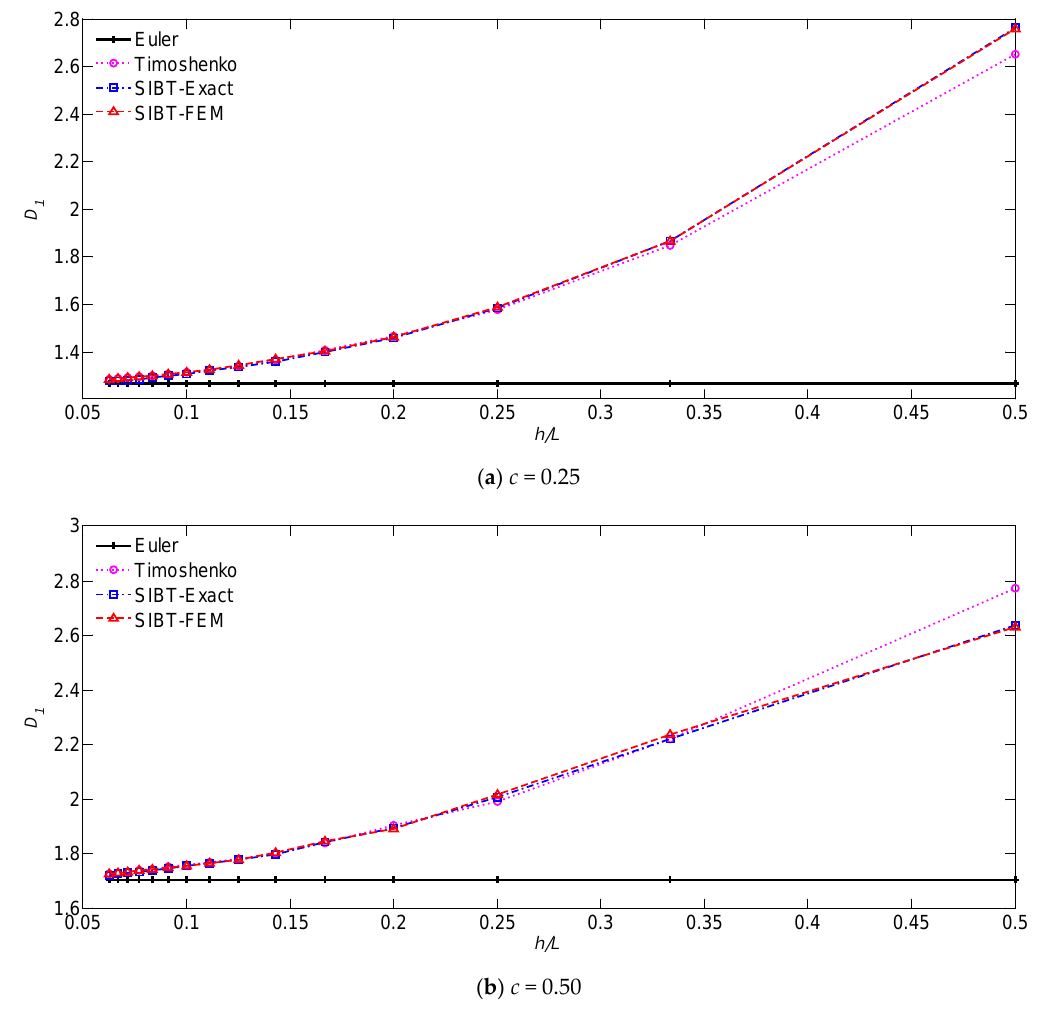
Figure 10. Dynamic magnification factors of the beam with different slenderness ratios.